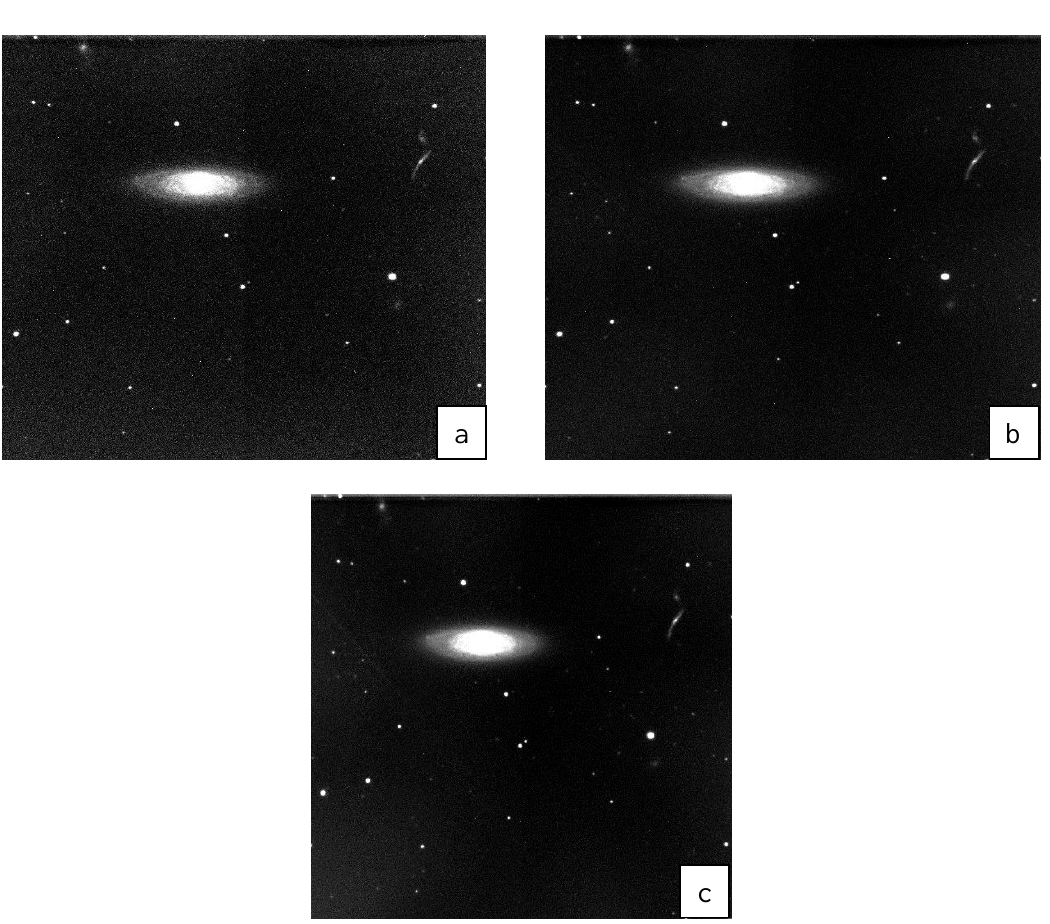
Fig. 2: CCD image of NGC 4448 after reduction (a) B filter (b) V filter (c) R